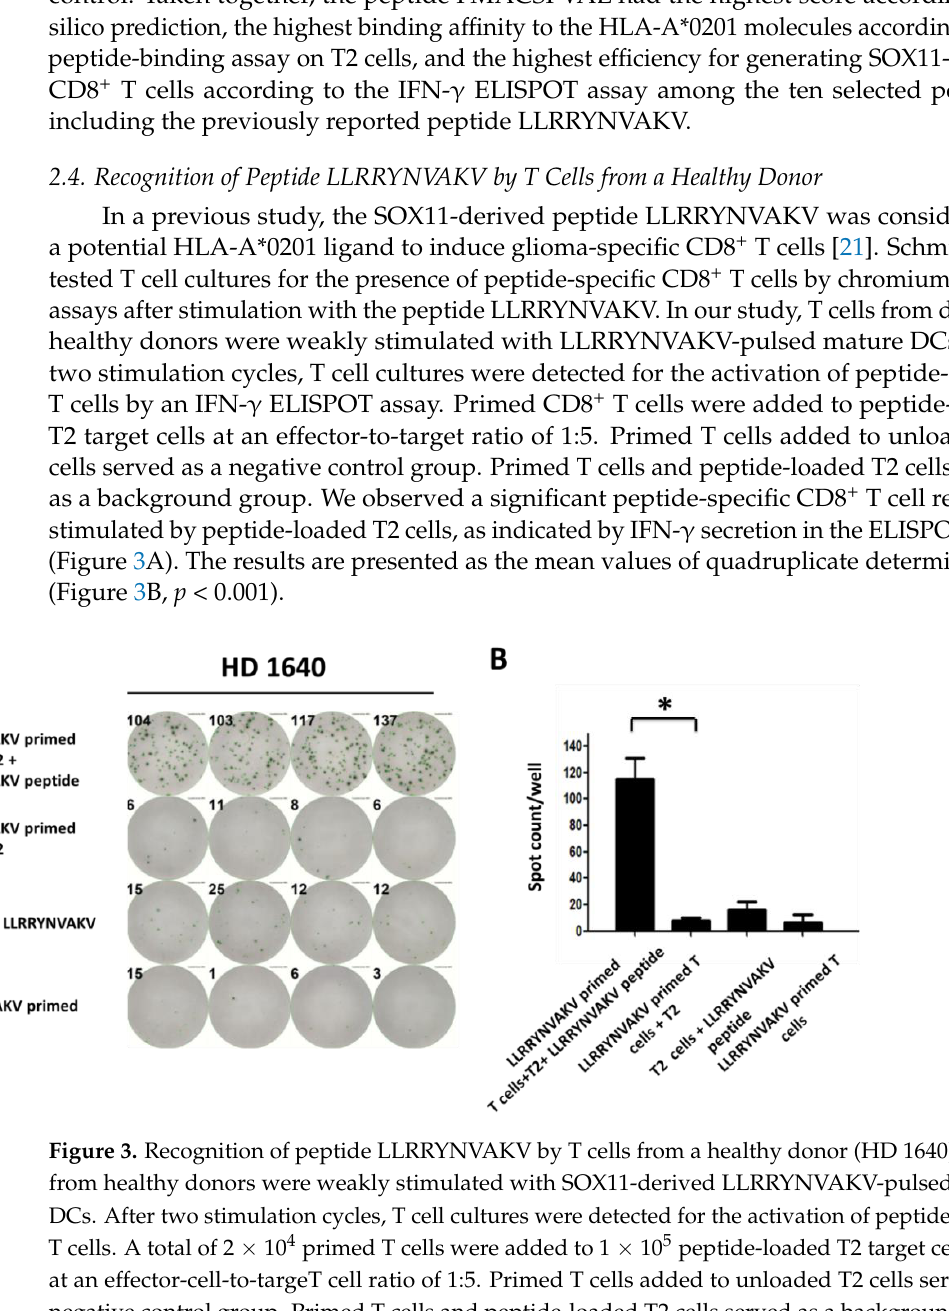
paired-sample t -test and is indicated by * for p values < 0.05.